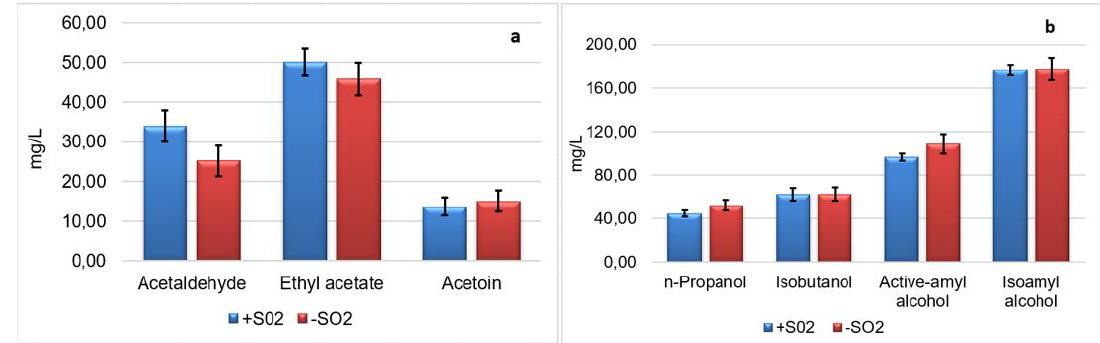
Figure 5. Main volatile compounds ( a ) and ( b ) produced during pilot-scale vinifications by mixed starter (ND-SA) in two trials carried out with (+SO 2 ) and without SO 2 addition (-SO 2 ). Data are expressed in mg/L and are mean ± SD of two independent experiments. Different letters (a,b,) correspond to statistically significant differences ( p ≤ 0.05).